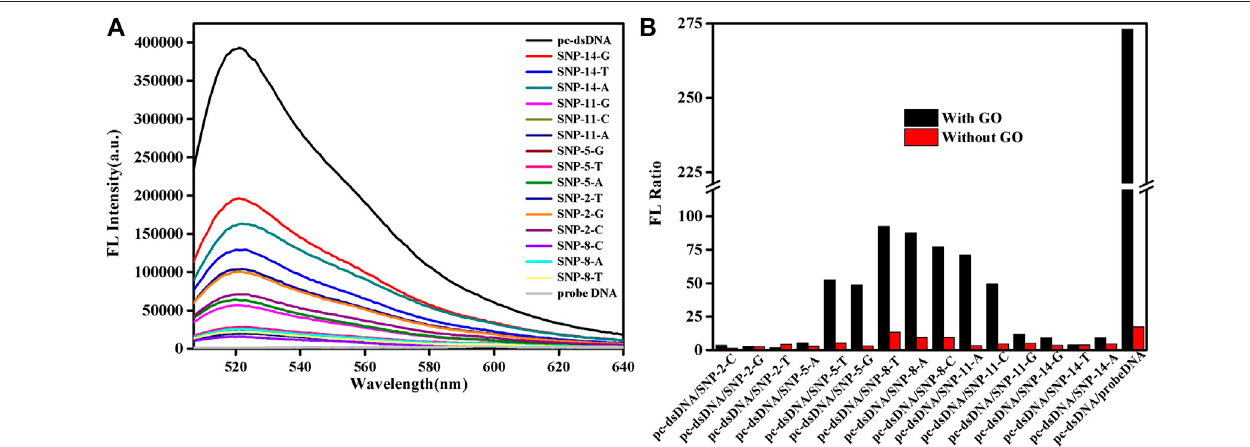
FIGURE1| Emissionspectraofabiosensorconsistingofgrapheneoxide(GO)andSYBRGreenI(SG)thatdetectssinglenucleotidepolymorphisms(SNPs). (A) FL intensitiesofthesamplesafteraddingGO. (B) FLintensitiesasafunctionofvariousDNA/SG/GOorDNA/SG.The fi nalconcentration:[SNPs] (cid:2) 10nM,[probeDNA] (cid:2) 10nM,